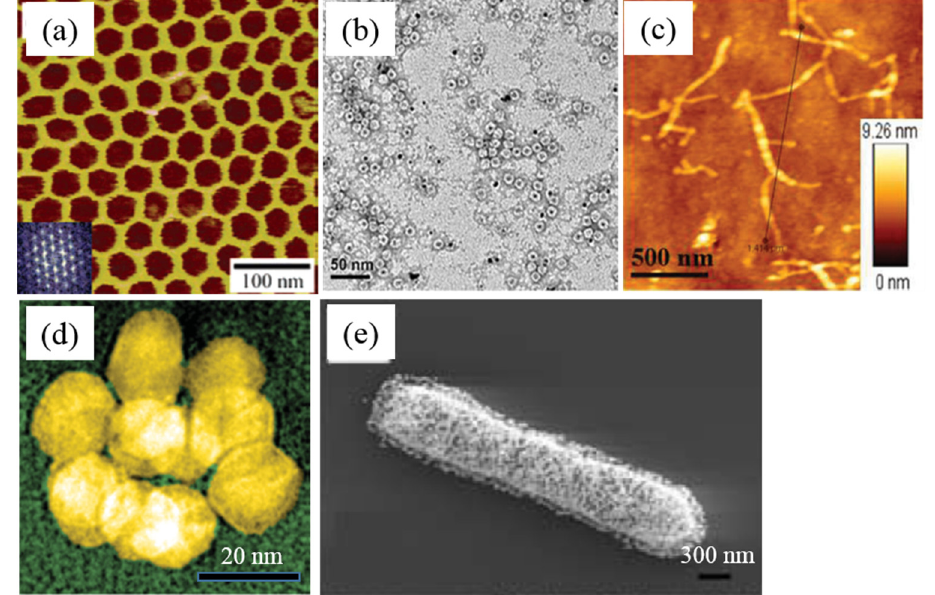
Figure 1. Biomimetic nanostructures: ( a ) DNA 2D structure (Reprinted with permission from [29], published by American Chemical Society, 2005); ( b ) ferritin ‐ based Pt NPs (Reprinted with permission from [31], published by American Chemical Society, 2013); ( c ) peptide nanofiber ‐ graphene quantum dot hybrids (Reprinted with permission from [32], published by WILEY ‐ VCH Verlag GmbH & Co., 2015); ( d ) virus ‐ protein hybrid nanostructures [33]; ( e ) bacterium ‐ based NPs (Reprinted with permission from [34], published by WILEY ‐ VCH Verlag GmbH & Co., 2005).